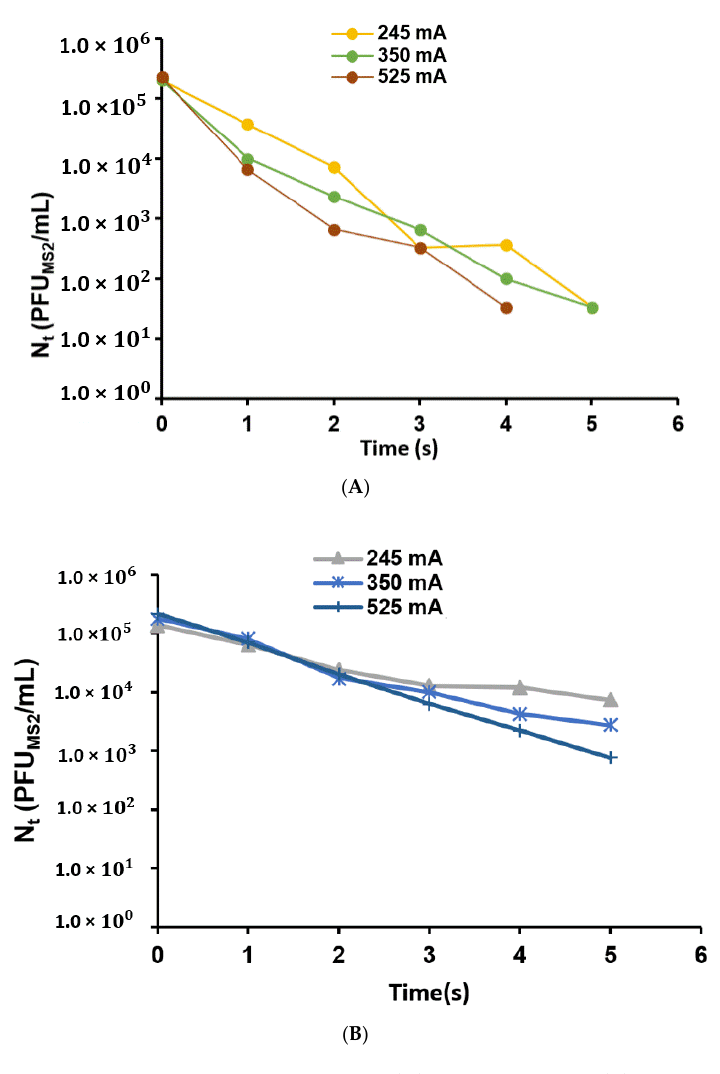
Figure 3. Change in MS2 concentration over time ( A ) UVT 275 = 97%; ( B ) UVT 275 = 90% in the bench-scale experiments.